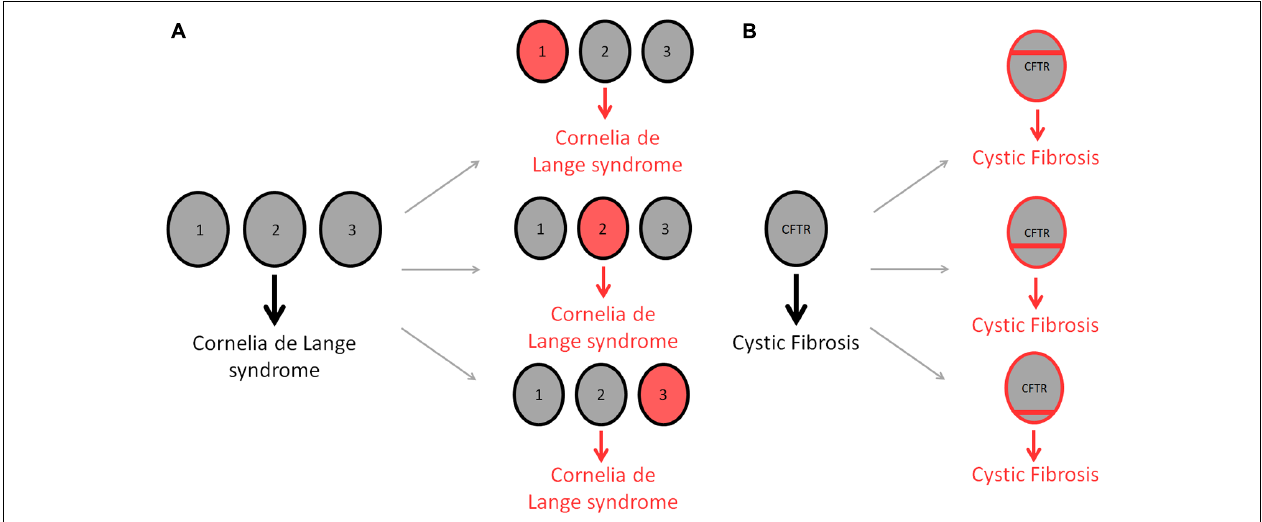
the same disorder in each case (Liu and Baynam, 2010). Allelic heterogeneity describes the ability of different mutations within the same gene to cause the same disease (B) . Cystic fibrosis is used to demonstrate this form of heterogeneity, with as many as 1,500 CFTR mutations being attributed to causing the disorder (O’Sullivan and Freedman, 2009). Red bars indicate different mutations within the CFTR